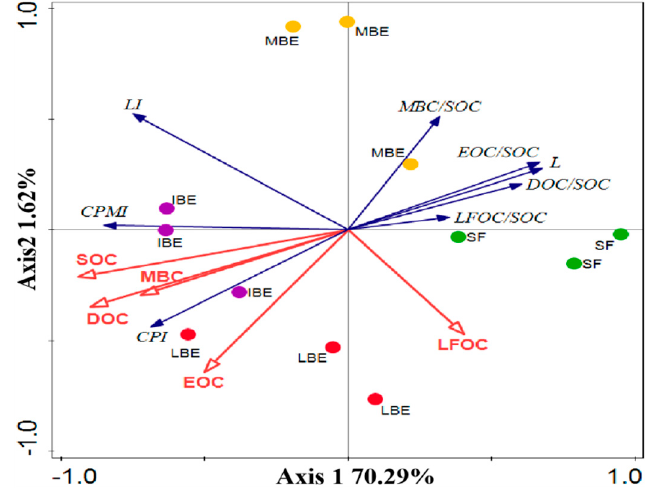
Figure 7. Redundancy analysis of correlation indexes between SLOCFs and SOC under different bedrock exposure rates in karst rock desertification area. SF (secondary forest); LBE (light bedrock exposure); MBE (moderate bedrock exposure); IBE (intense bedrock exposure). LI (liability index); CPMI (carbon pool management index); CPI (carbon pool index); and L (soil liability of carbon). SOC (soil organic carbon); MBC (microbial biomass carbon); DOC (dissolved organic carbon); EOC (easily oxidized organic carbon) and LFOC (light fraction organic carbon). Table 2. Statistical table of redundancy analysis of soil labile organic carbon fractions and organic carbon related indexes.